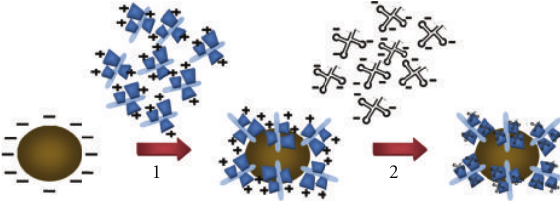
Figure 3: Hypothetical formation of biomolecular triconjugates of GNPs, protamine, and nucleic acid (figure not drawn to